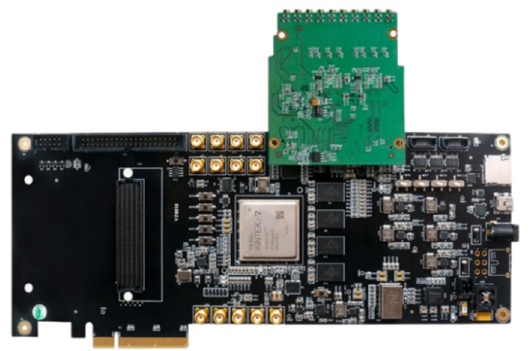
Figure 8. TIADC test system.